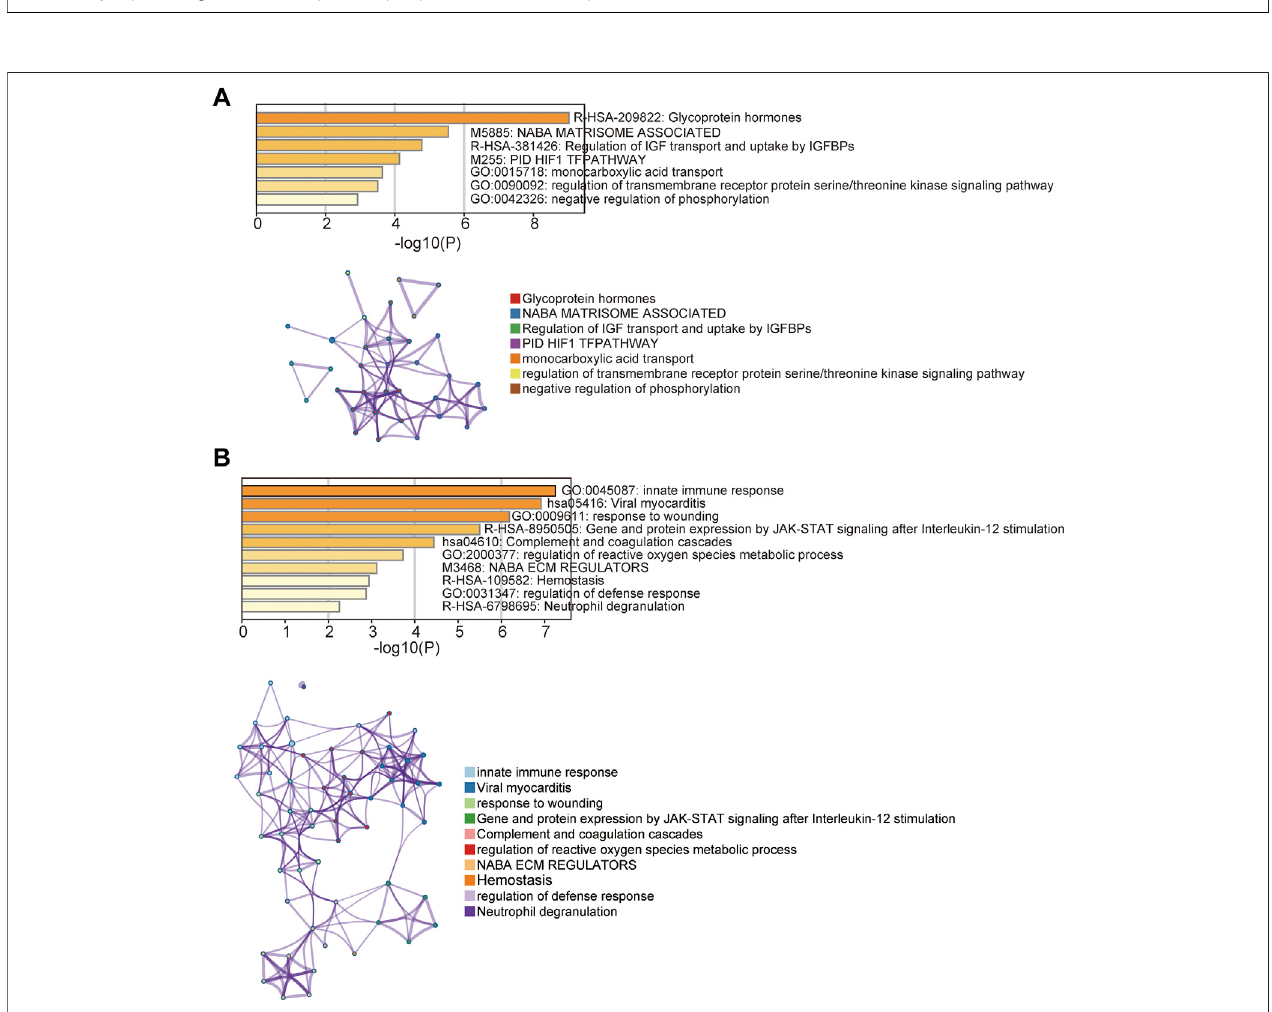
Frontiers in Genetics |